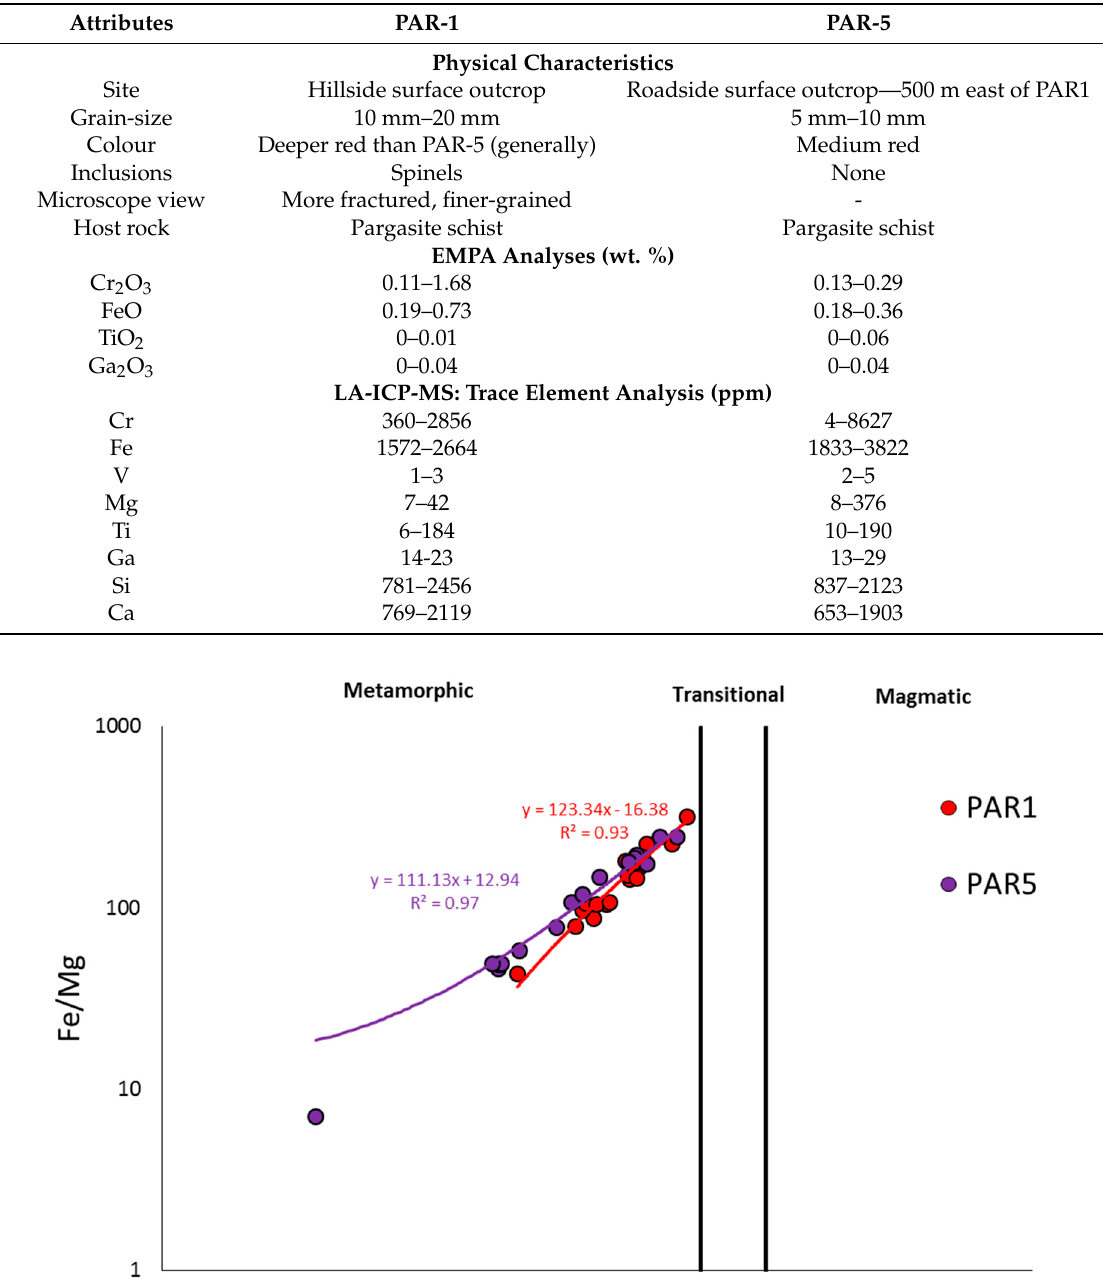
Table 1. Summary of prior Paranesti ruby results (Wang et al. 2017 [18]).